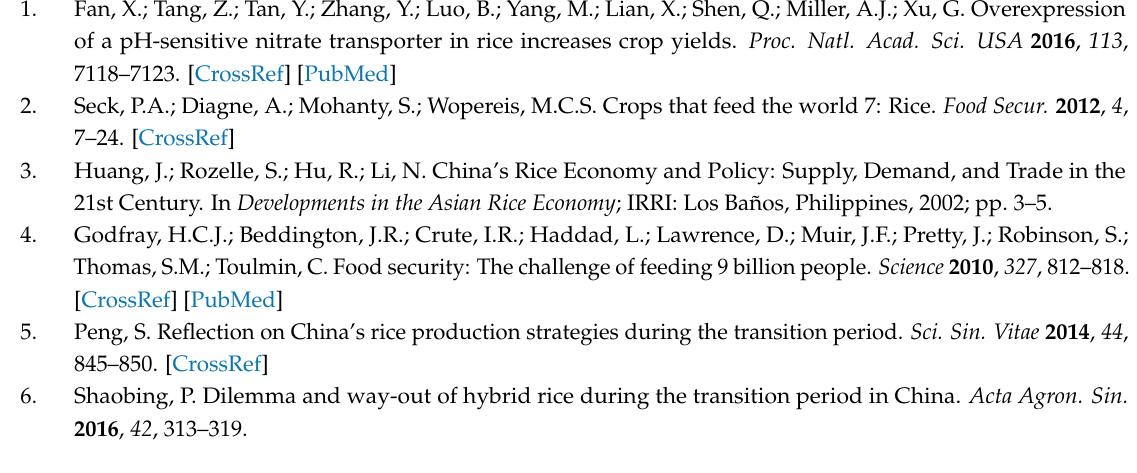
Table S1: ORYZA (v3) evaluation results for crop growth variables simulations for calibration data set over the entire growing season; Table S2: ORYZA (v3) evaluation results for crop growth variables simulations for validation data set over the entire growing